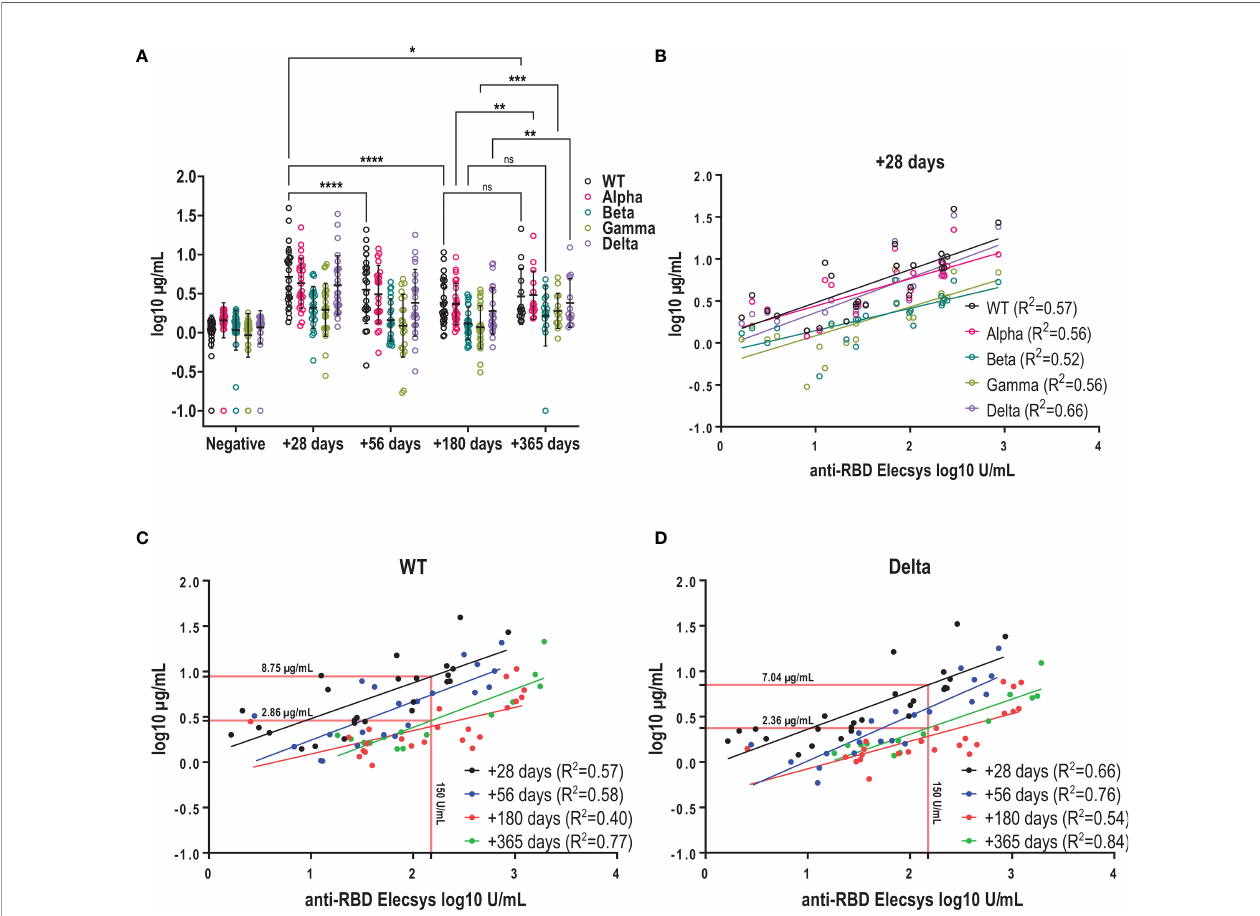
FIGURE 4 | Kinetics of neutralizing antibodies against the infectious strain and variants of concern. (A) Kinetics of neutralizing antibody titres of WT and VOCs using a surrogate RBD-ACE2 binding inhibition assay. Mean +/- SD is shown in black. Antibodies with neutralizing capacity against the WT were stable between 6 and 12 months (mean as log (µg/mL) +180 days vs +365 days: 0.38 ± 0.3 vs 0.46 ± 0.36) (B) Correlation between log-transformed anti-RBD and neutralizing antibody titers against SARS- CoV-2 WT and variants using linear regression. (C + D) Correlation between anti-RBD and neutralizing antibody titres for WT and Delta variant at the different time points post infection. Red lines show interpolated neutralizing titre at an anti-RBD titres of 150U/mL. ns, not signi fi cant; ****p < 0.0001; ***p < 0.001; **p < 0.01; *p <